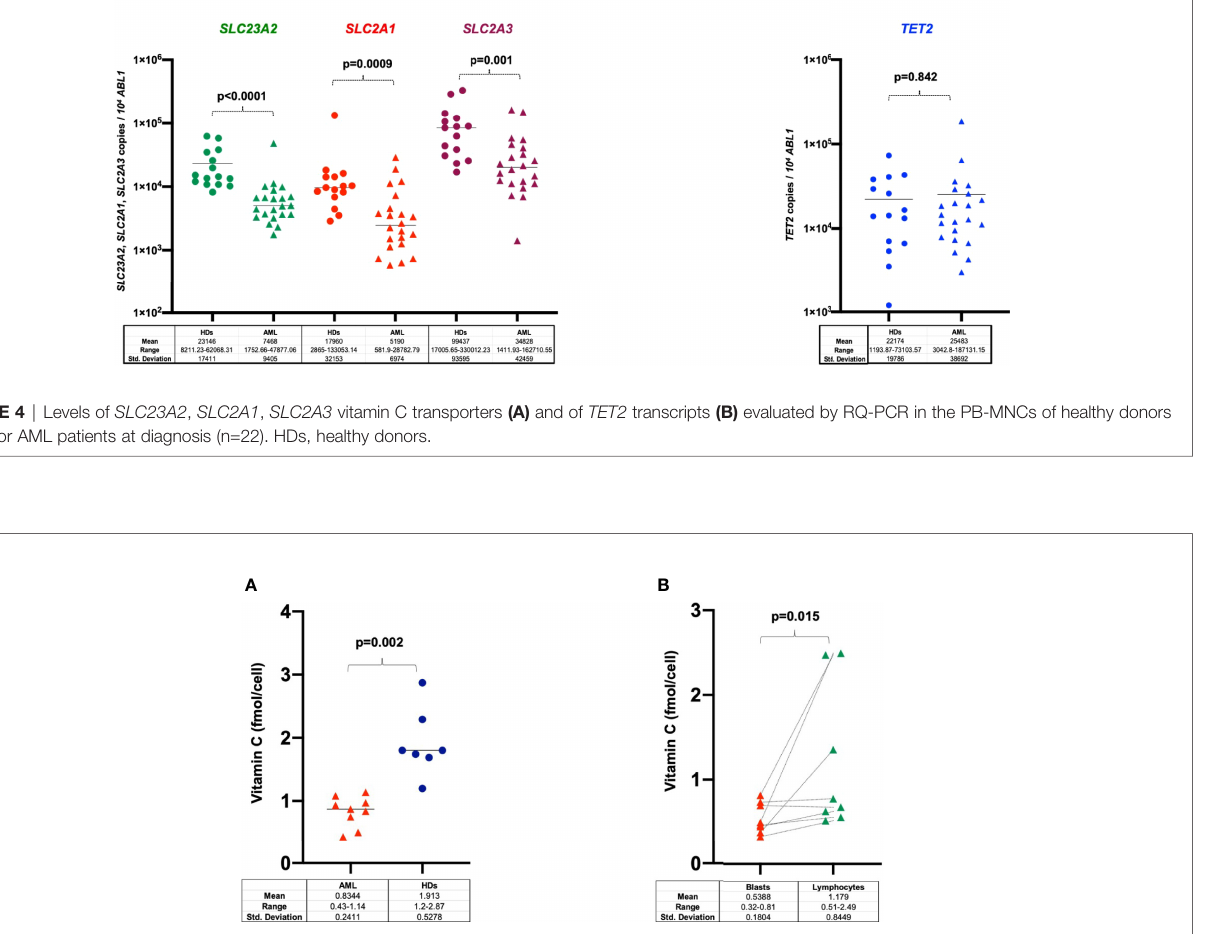
FIGURE 5 | Intracellular concentration of vitamin C in (A) PB-MNCs at diagnosis (n=9), healthy donors (n=7) and in (B) blasts and lymphocytes puri fi ed from AML patients at disease onset (n=8). HDs, healthy donors.